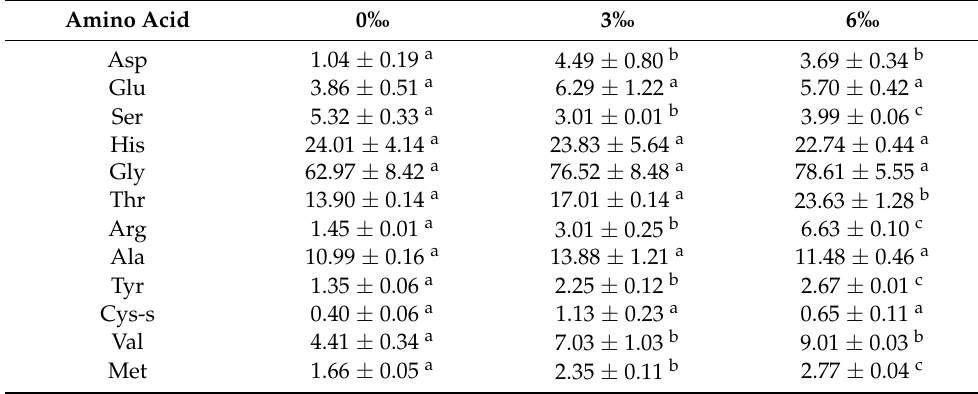
Data are mean ± SE. Different lowercase letters (a, b) in a row indicate significant differences among different salinities ( p < 0.05). TAA = total amino acids; EAA = essential amino acids (His, Thr, Val, Met, Phe, Ile, Leu, Lys); NEAA = non-essential amino acids (Asp, Glu, Ser, Gly, Arg, Ala, Pro, Hyp). Table 2. Free-amino-acid composition of muscle of grass carp cultured at different salinities (mg/g dry weight